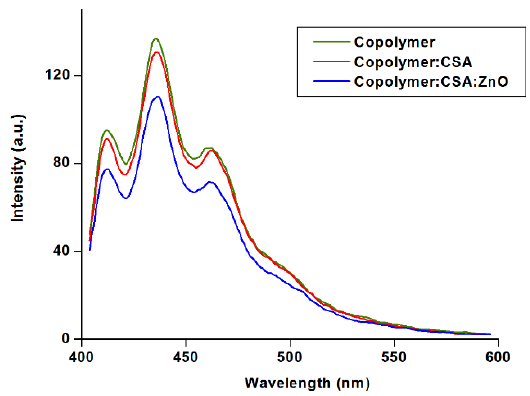
Figure 5. Photoluminescence